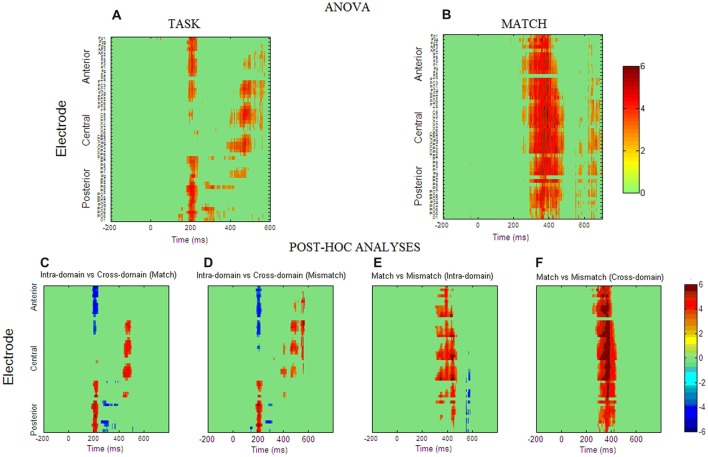
Spatio-temporal maps obtained from repeated measures ANOVA analysis for factor TASK (A) and factor MATCH (B). The ANOVA p-values were transformed to Z scores for clarity of interpretation. The Z statistics of those space-time points that fulfill the false discovery rate (FDR) criterion are presented in a color scale. The interaction between the two factors was not significant for any space-time point. (C–F) Spatio-temporal maps obtained from post hoc test computed at those space-time points where the main effects were reported as significant. The maps are presented in t-statistic and were thresholded with the FDR criterion (q = 0.05).